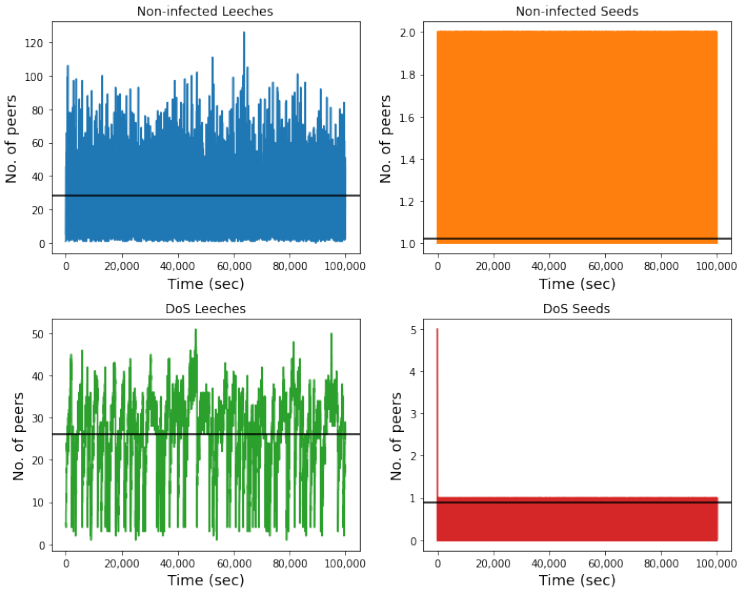
Figure 12. Time evolution of the P2P system with δ = 5 nodes affected by the DoS